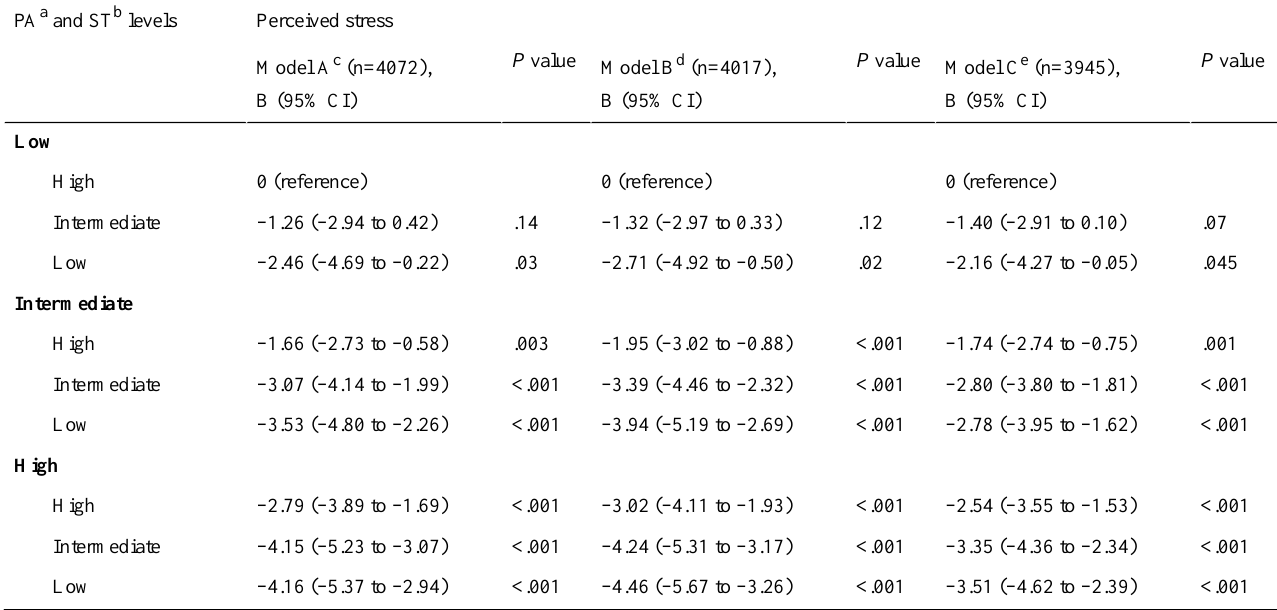
Table 3. Combined associations of physical activity levels and sedentary time on perceived stress. Perceived stressPA a and ST b